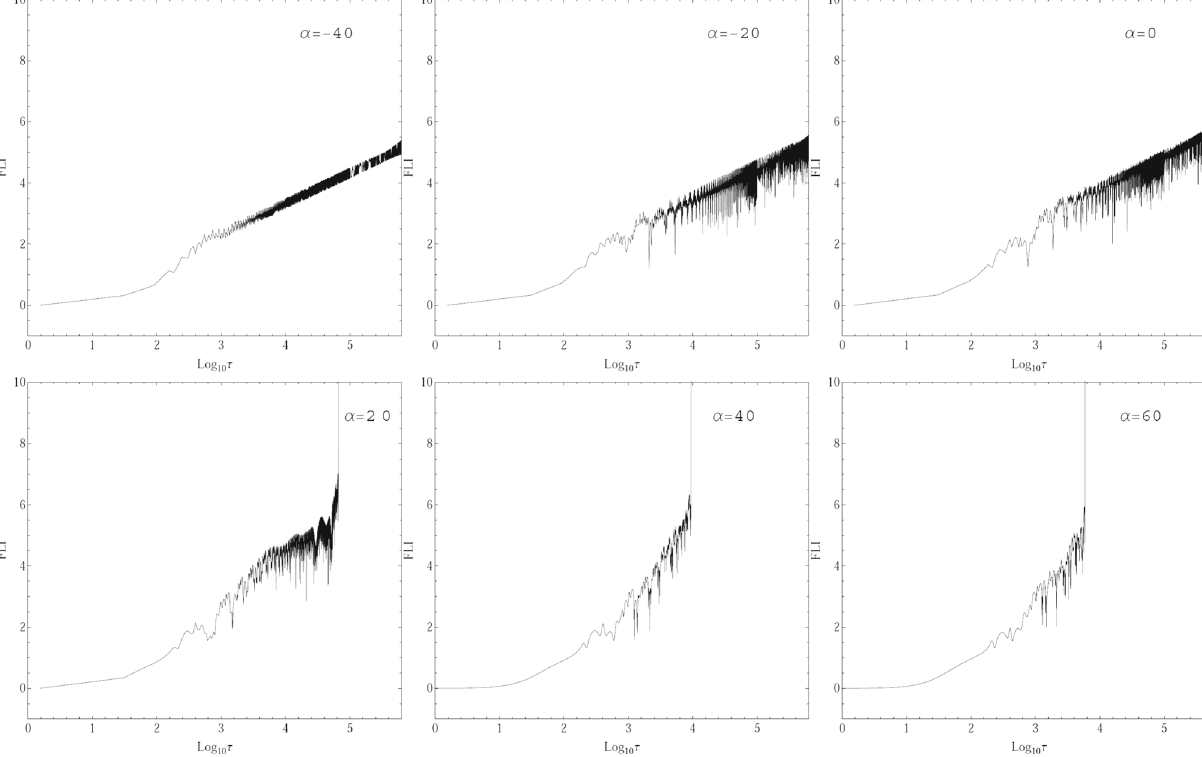
Fig. 3 The Fast Lyapunov indicators with two nearby trajectories for the solutions plotted in Fig.